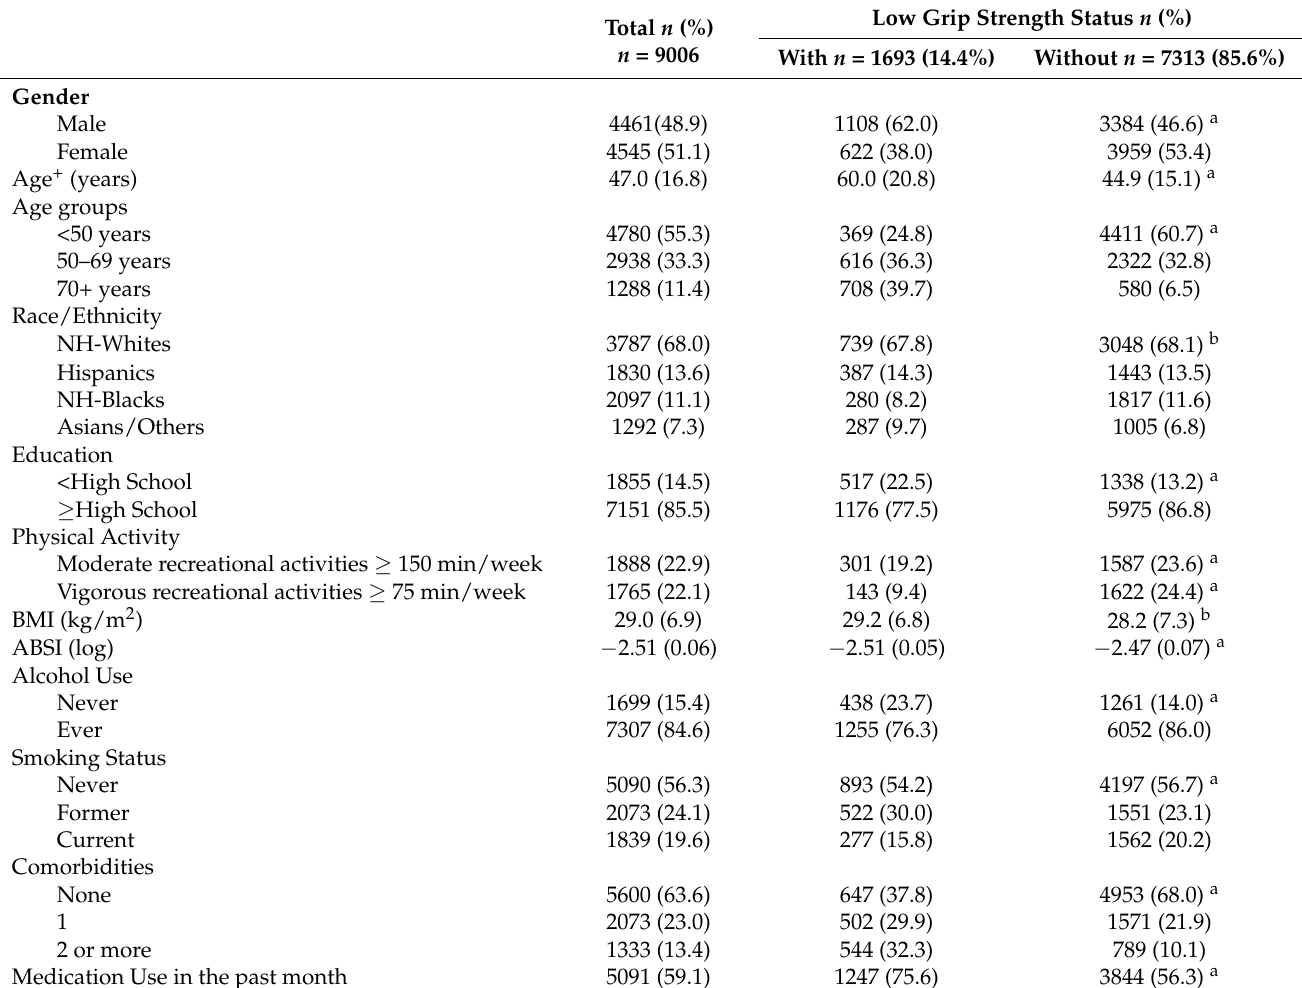
Table 1. Study characteristics by grip strength status in U.S. adults (Age ≥ 20 years) NHANES 2011–2014, n = 9006.